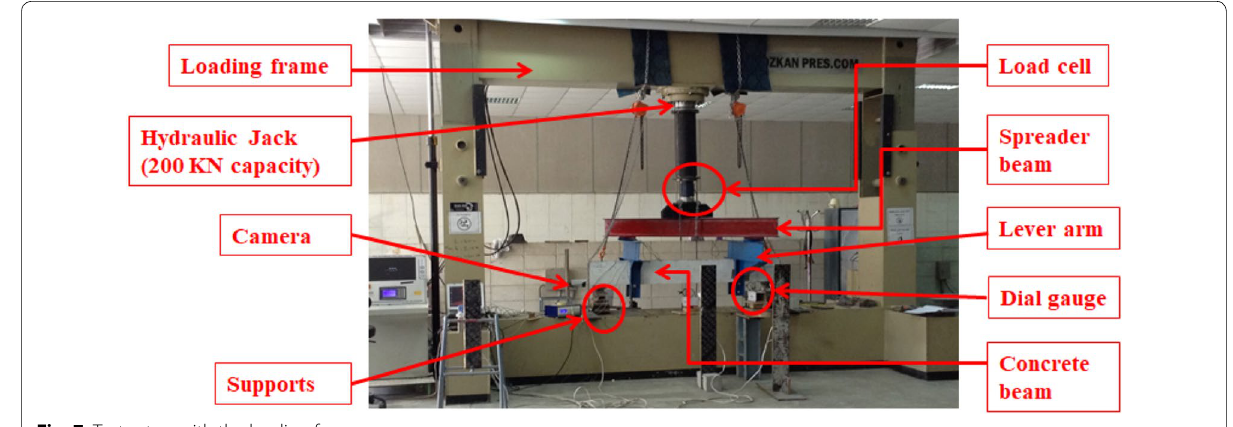
Fig. 7 Test setup with the loading frame.